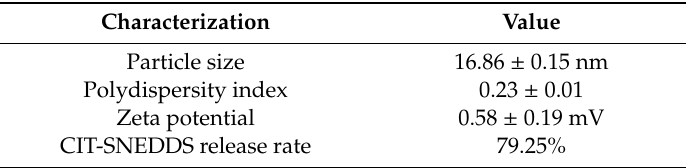
Table 4. The summary of characterization of Citral-loaded self nano-emulsifying drug delivery system (CIT-SNEDDS).